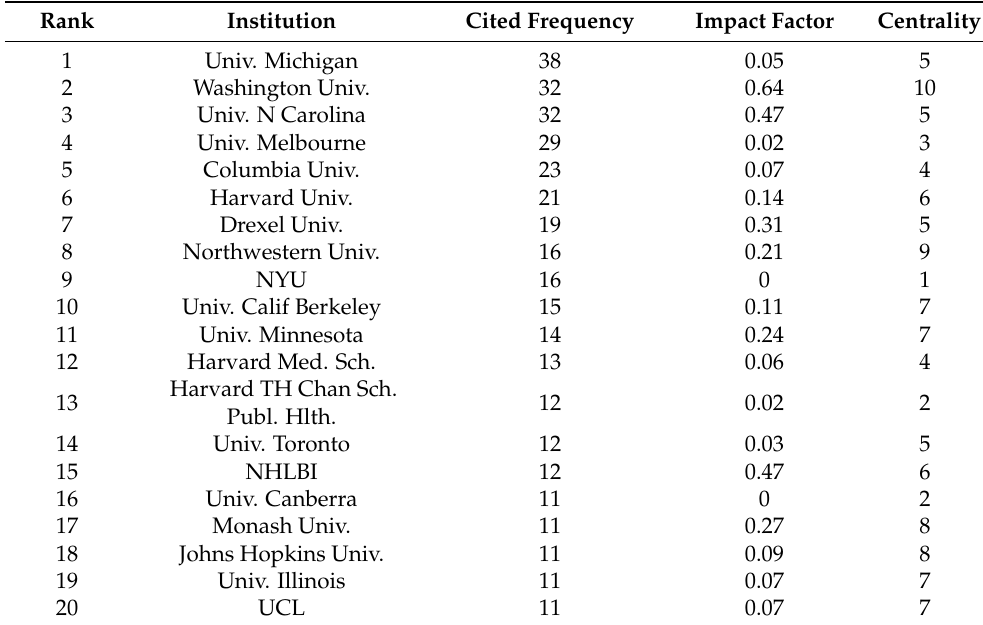
Figure 4. Knowledge map of co-institution collaboration network. Table 2. The top 20